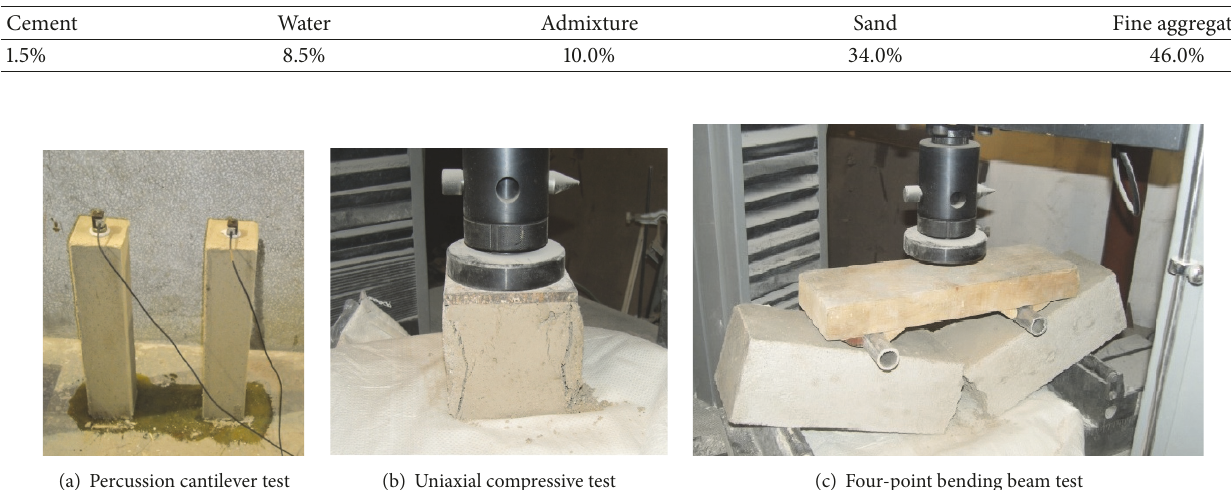
Figure 2: Model material tests for mechanical proportions